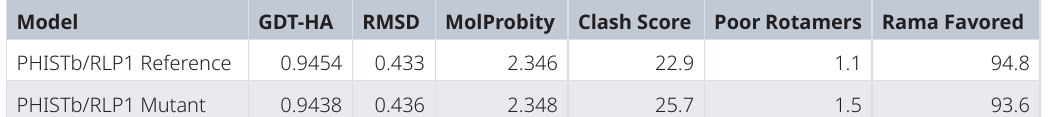
Table 4. Galaxy refine scores for the best model of the protein structures for PHISTb/RLP1 reference and mutant proteins after structure refinement. The score considered included the poor rotamers scores in which they are very low in both inferring to correction in R chain conformations. The Rama favored scores were also used to consider the models. The scores above 90 for Rama favored shows that the models are good to be used for further